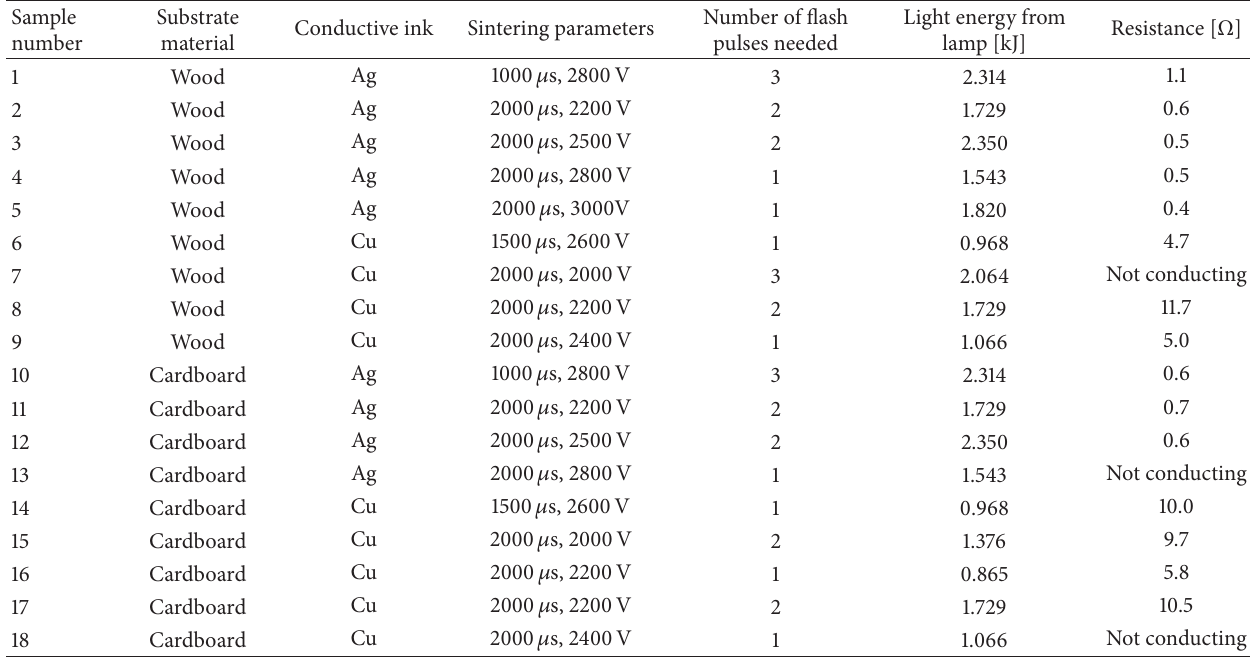
Table 1: Sintering parameters and resistance measurements.